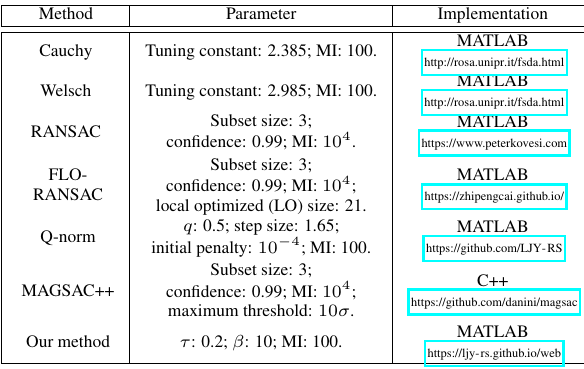
Figure 3. Feature matching results of the proposed model with different values of τ . Method Parameter Implementation